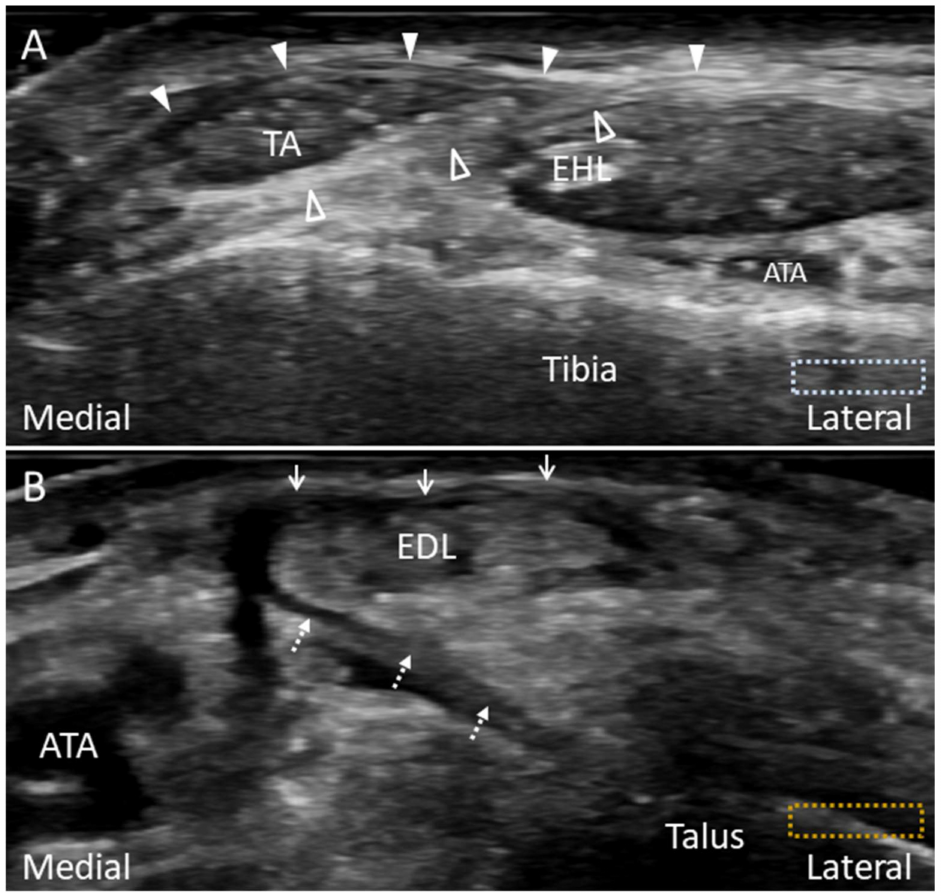
Figure 17. Imaging of the superior extensor retinaculum ( A ) and frondiform ligament of the inferior extensor retinaculum ( B ). The superior extensor retinaculum divides into the superficial (arrowheads) and deep (void arrowheads) layers, forming a separate tunnel for the tibialis anterior tendon (TA) ( A ). The lateral (arrows) and medial (dotted arrows) roots of the frondiform ligament can be seen attaching to the sinus tarsi ( B ). The colored dashed rectangles are in accordance with the transducer positions in Figure 3C. ATA: anterior tibial artery; EHL: extensor hallucis longus; EDL: extensor digitorum longus. The SPR and IPR are evaluated by placing the probe along their long axes (Figure 18A,B). In SPR injuries, the complex of the triangular fibrocartilage on the fibula and the peroneal tendons should also be evaluated for stability by asking the patients to forcefully dorsiflex and evert their ankles (). Unstable peroneal tendons may be subluxed anterior to the peroneal groove or onto the tip of the lateral malleolus secondary to the stripping injury, avulsion or rupture of the SPR [41]. The FR is depicted with the transducer placed along the axial oblique plane posterior to the medial malleolus (Figure 18C). Dynamic examination with active ankle dorsiflexion and inversion can also be performed for examining the stability of the TP tendon